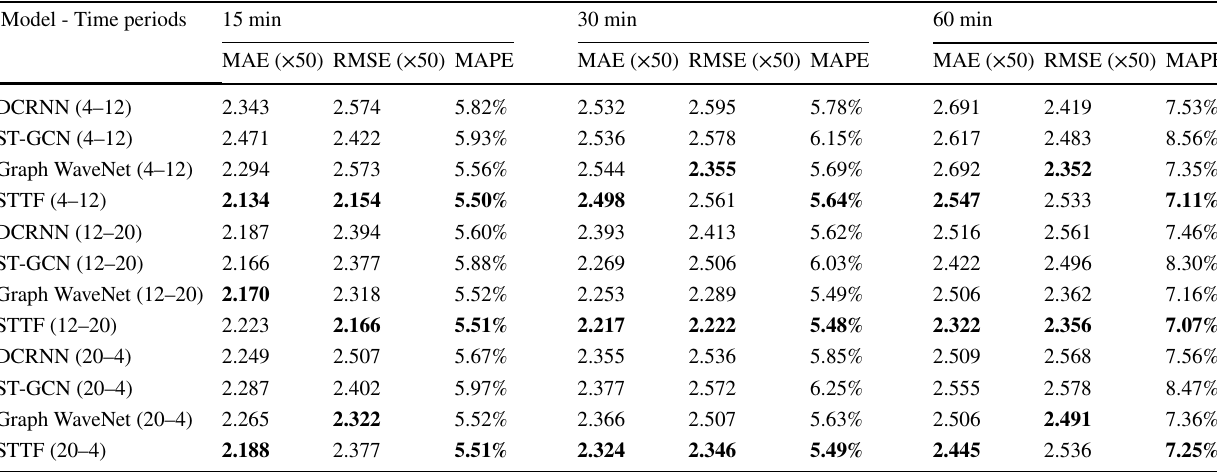
Table 3 Performance of each model with different time intervals and same prediction time steps at different time periods of the day (predictions are made every 30 minutes and the optimal values within the same time period are bolded)